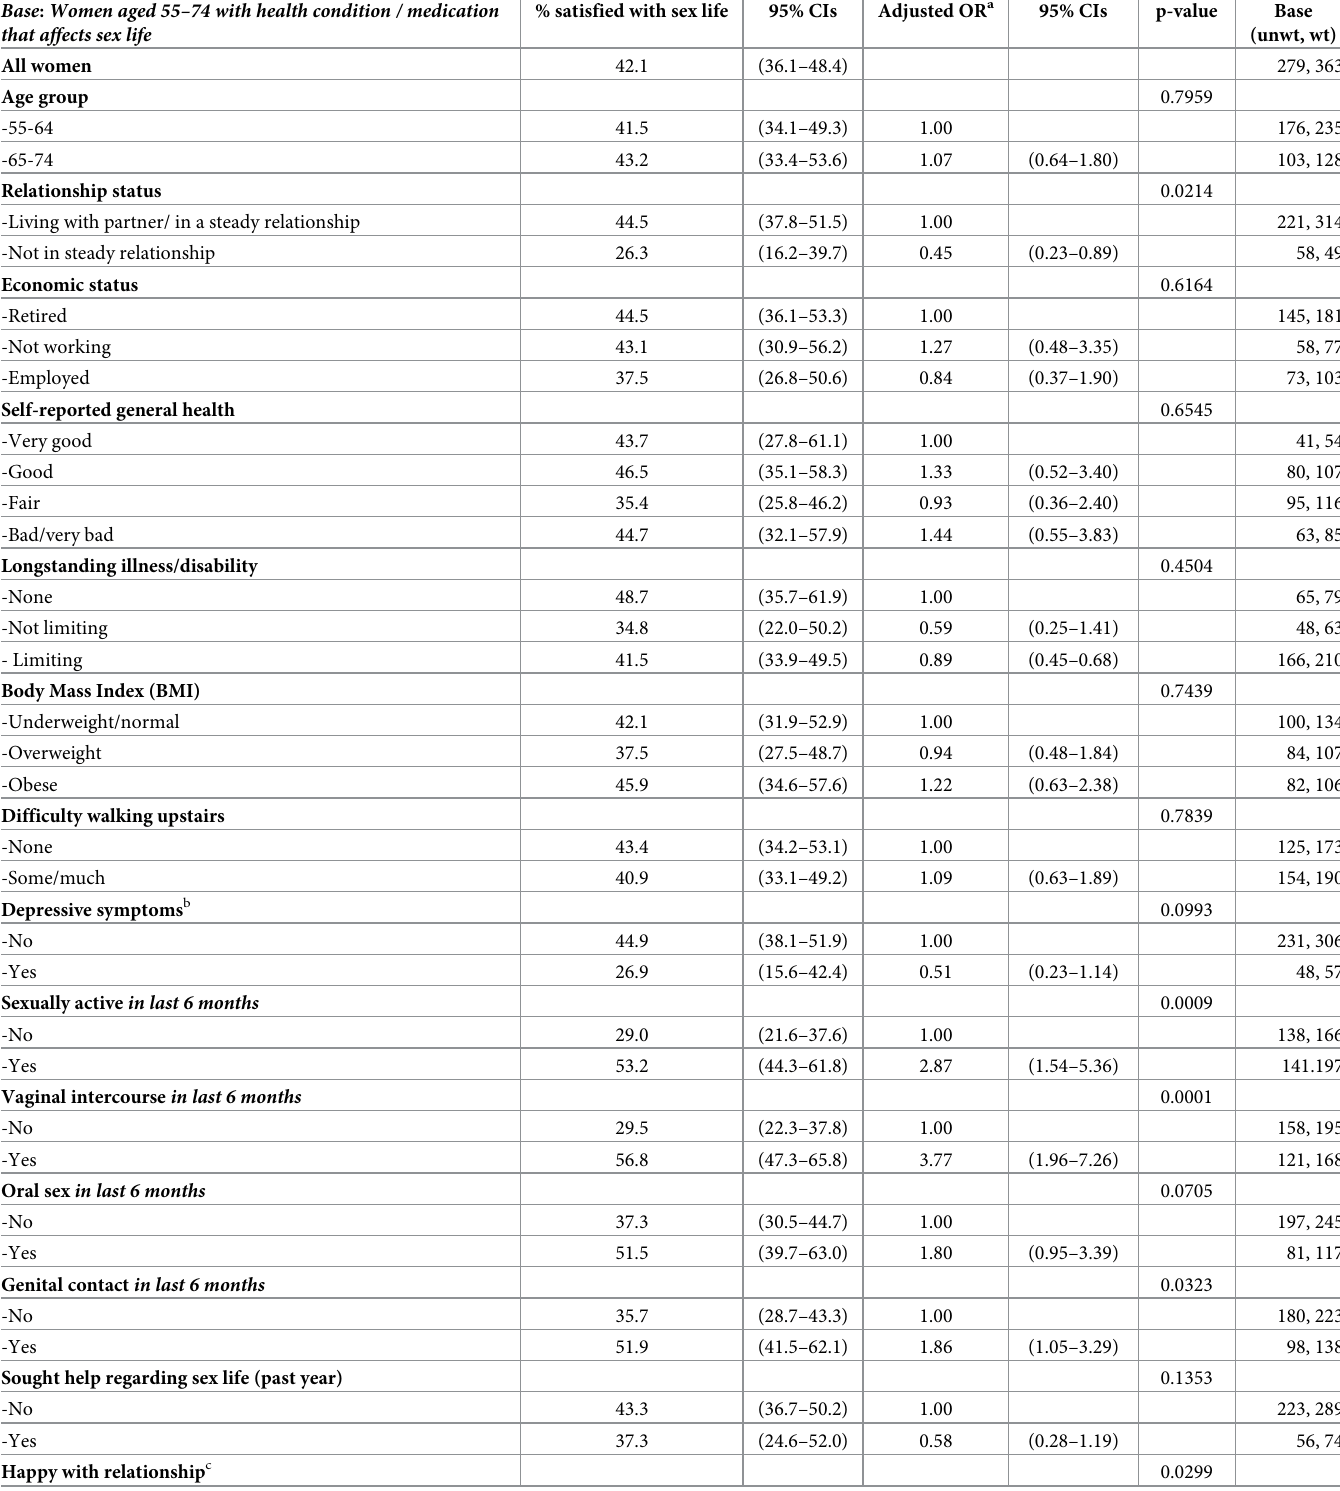
Table 6. Satisfied with sex life: